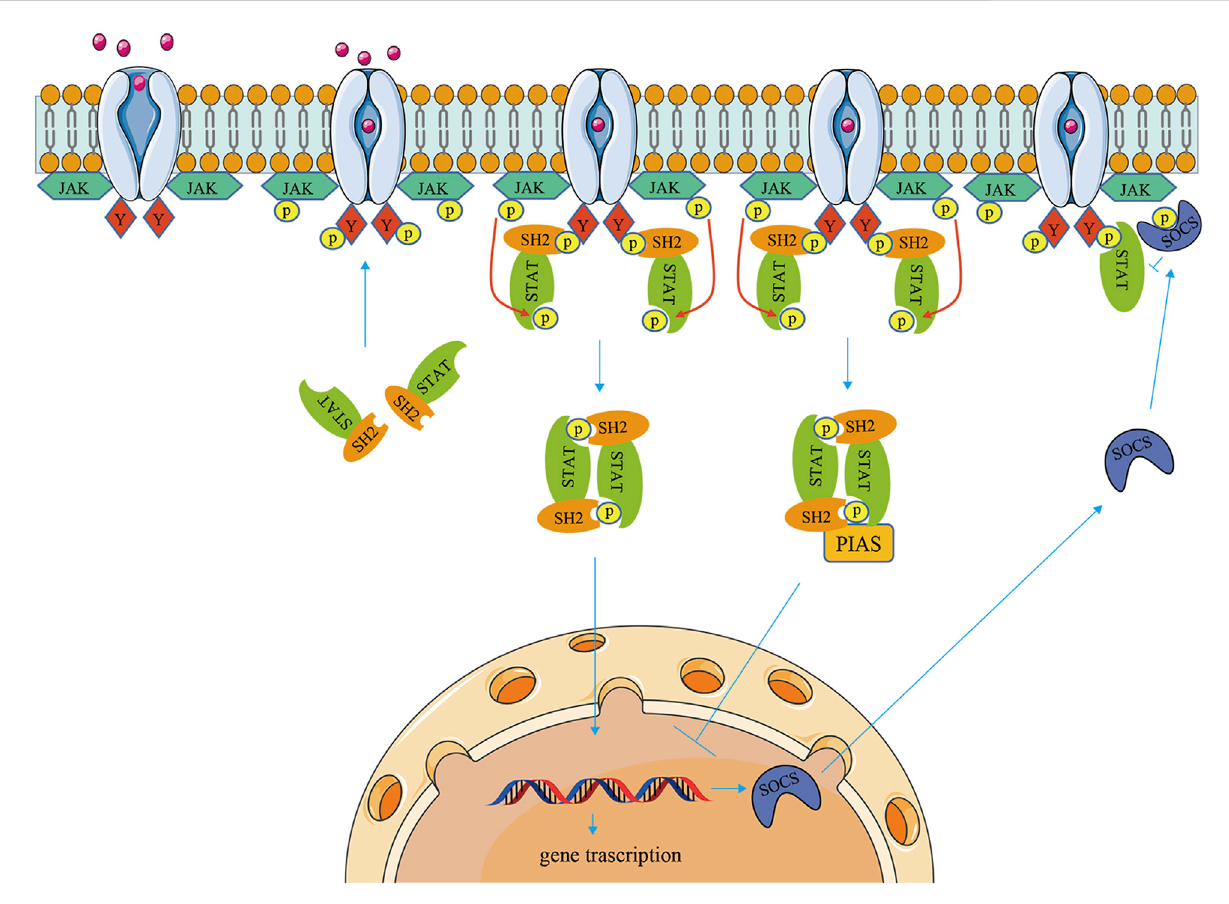
FIGURE 1 The signaling mechanism of the JAK/STAT pathway. When cytokines bind to transmembrane receptors, receptor-associated JAKs are activated, whichthenphosphorylateSTATproteins.ActivationofSTATproteinsformshomo-orheterodimersthataretransferredtothenucleusandregulategene transcription. The JAK/STAT pathway is negatively regulated through SOCS and